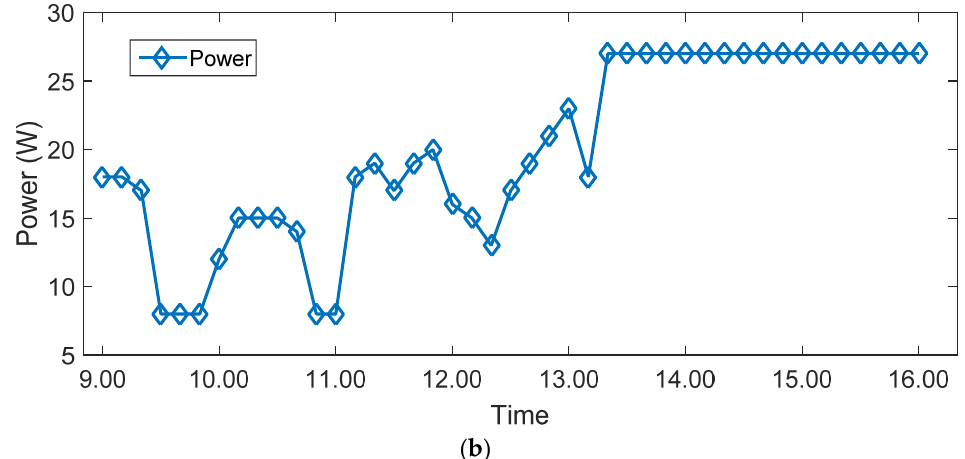
Figure 10. Data from experimental setup over the period of one day with daylight control circuit: ( a ) Illuminance on working plane; ( b ) Power consumption.